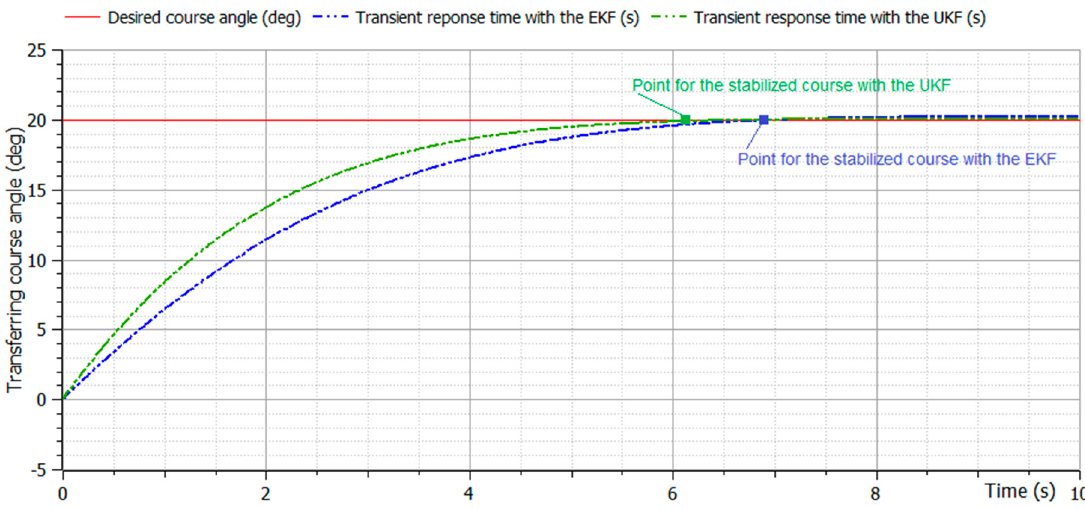
Figure 8. Average transient response time in a desired course of 020 ◦ from the current position for the cases using EKF and UKF.